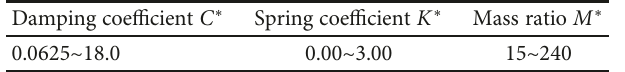
Table 1: Parameters considered in this